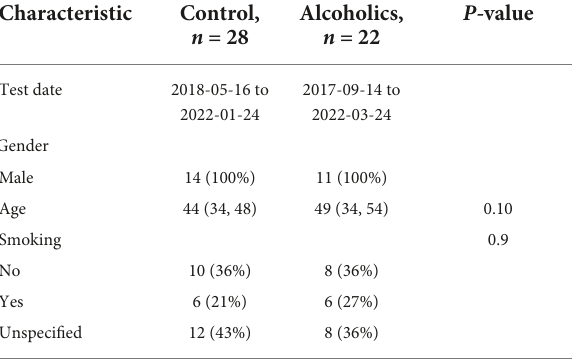
TABLE 1 Demographics and clinical data of the study subjects.